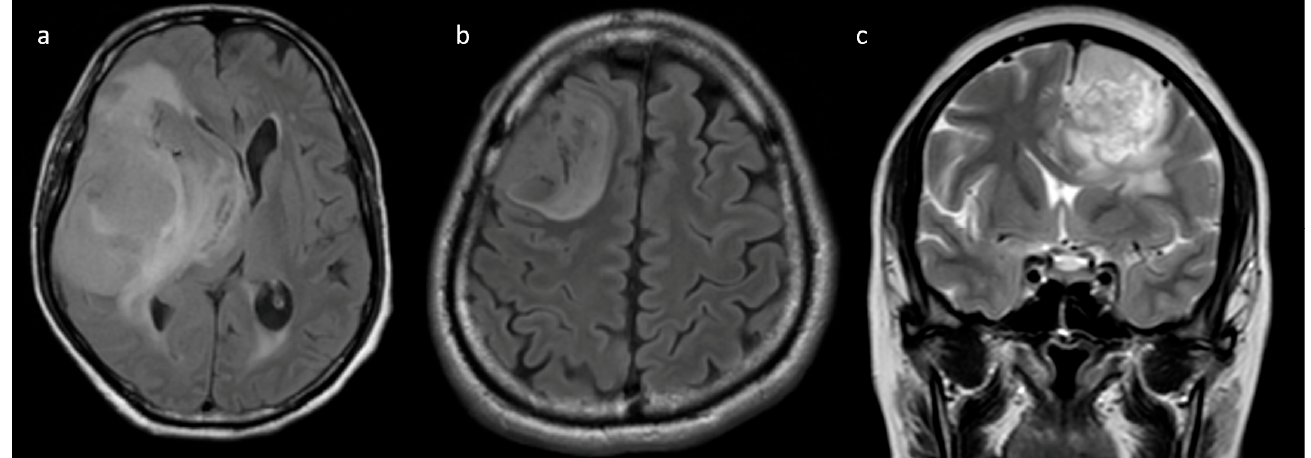
Figure 5. ( a , b ) Axial T2w and FLAIR images reveal intratumoral cysts with fluid-fluid levels within these cysts, suggestive of a hemorrhage.